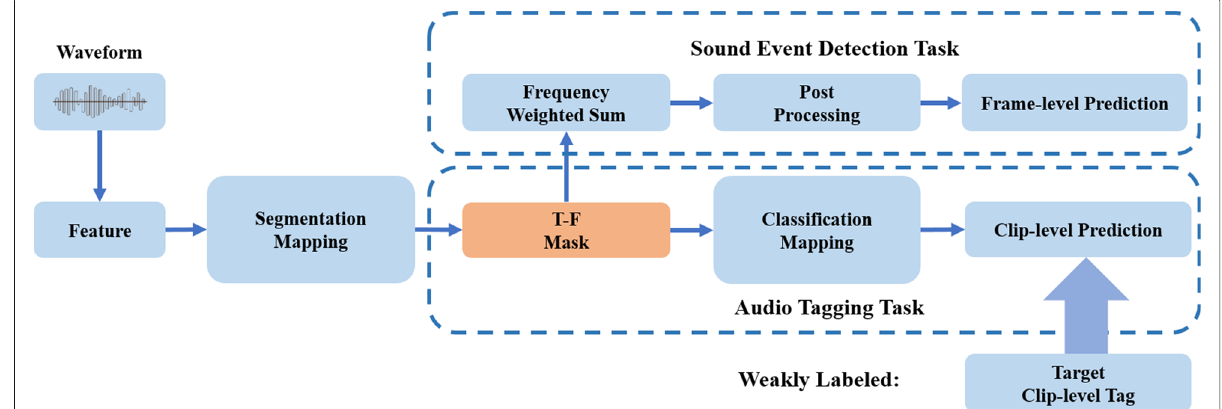
Fig. 1 Diagram of the proposed source-separation-based